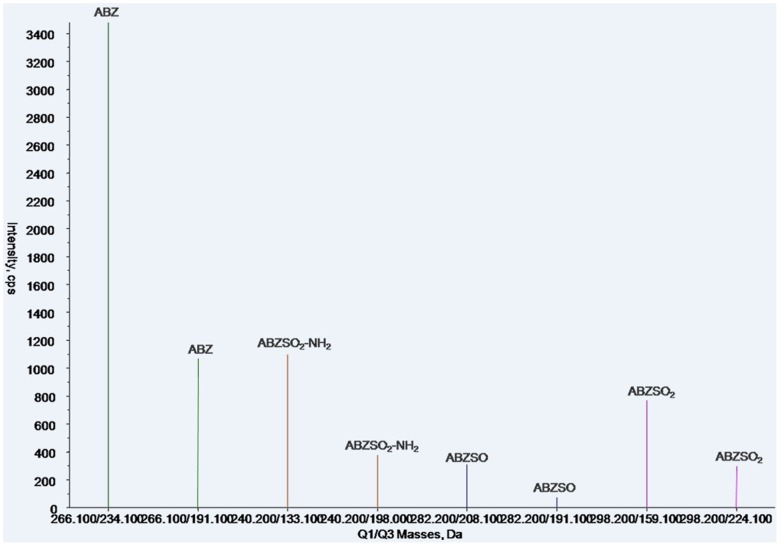
Total ion mass spectra of albendazole and metabolites.ABZ, albendazole; ABZSO, albendazole sulfoxide; ABZSO2, albendazole sulfone; ABZSO2-NH2, albendazole amino sulfone. Adjacent columns with the same color are two fragment ions from the same target analyte.